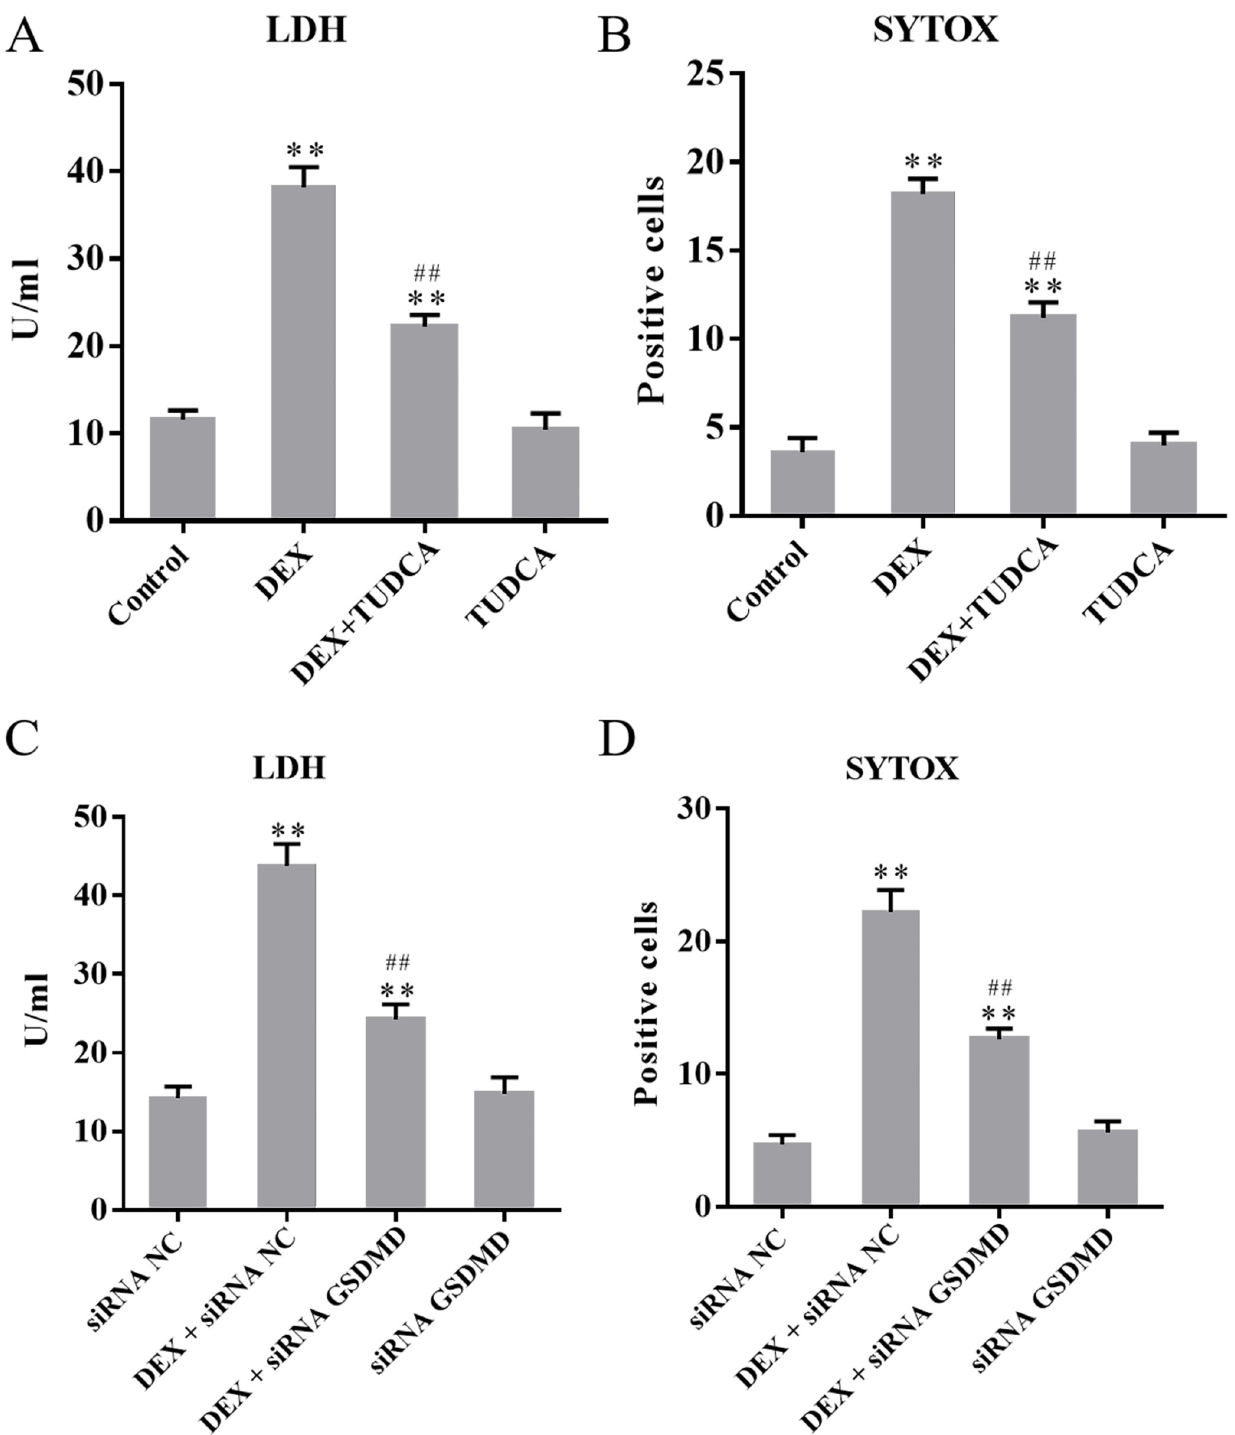
Fig 1. (A) The effect of DEX on the LDH leakage of PC12 cells (n = 5). (B) The effect of DEX on the number of SYTOX positive cells (n = 5). (C) The effect of DEX on the LDH leakage of PC12 cells (n = 5). (D) The effect of DEX on the number of SYTOX positive cells (n = 5). The release of LDH and the number of SYTOX green acid-positive cells were significantly increased after treatment with DEX, and TUDCA and siRNA GSDMD can significantly alleviate the effects of DEX. The data are shown as the mean ± SEM, �� P < 0.01 compared to the control group; ## P < 0.01 compared to the DEX group, �� P < 0.01 compared to the siRNA NC group; ## P < 0.01 compared to the DEX + siRNA NC group. DEX: dexamethasone; TUDCA: tauroursodeoxycholate; GSDMD: Gasdermin D.